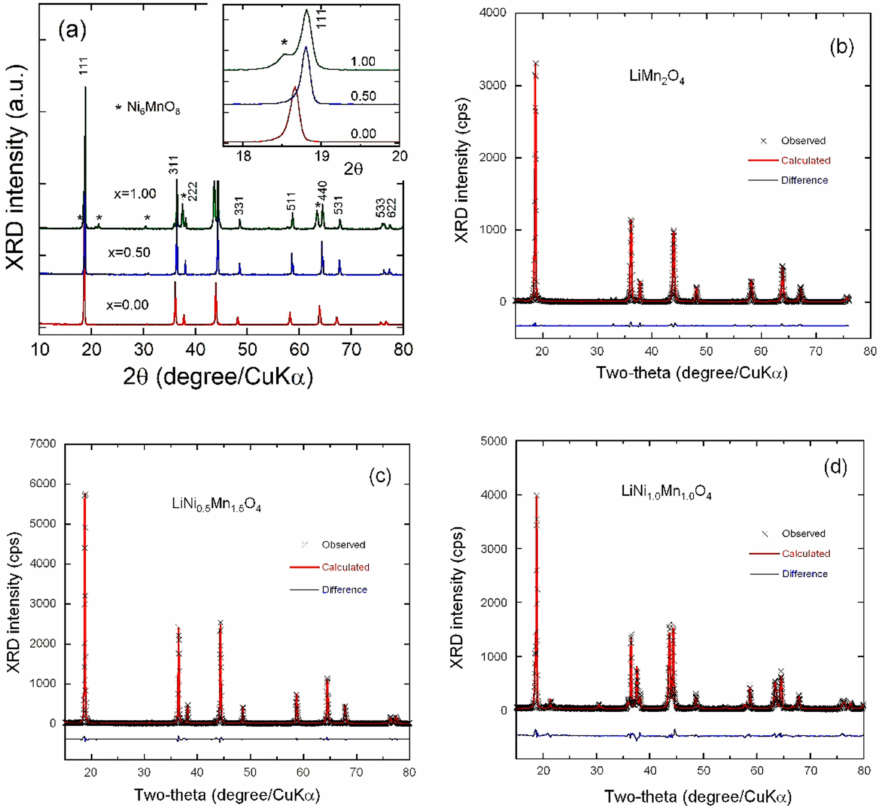
Figure 1. ( a ) XRD patterns of the as-prepared LiNi y Mn 2 − y O 4 ( y = 0.0, 0.5 and 1.0) spinel samples. The insert shows the reflections at ca. 2 θ = 18.8 ◦ . Stars (*) indicate reflections of Ni 6 MnO 8 impurity. ( b ) Rietveld refinement of Ni-rich LiNiMnO 4 . ( c ) Rietveld refinement of the 4-V spinel LiMn 2 O 4 . ( d ) Rietveld refinement of the 5-V LiNi 0.5 Mn 1.5 O 4 . Cross marks are experimental data and solid lines (in red) are calculated diagrams. The curve at the bottom (in blue) is the difference between the calculated and observed intensities.